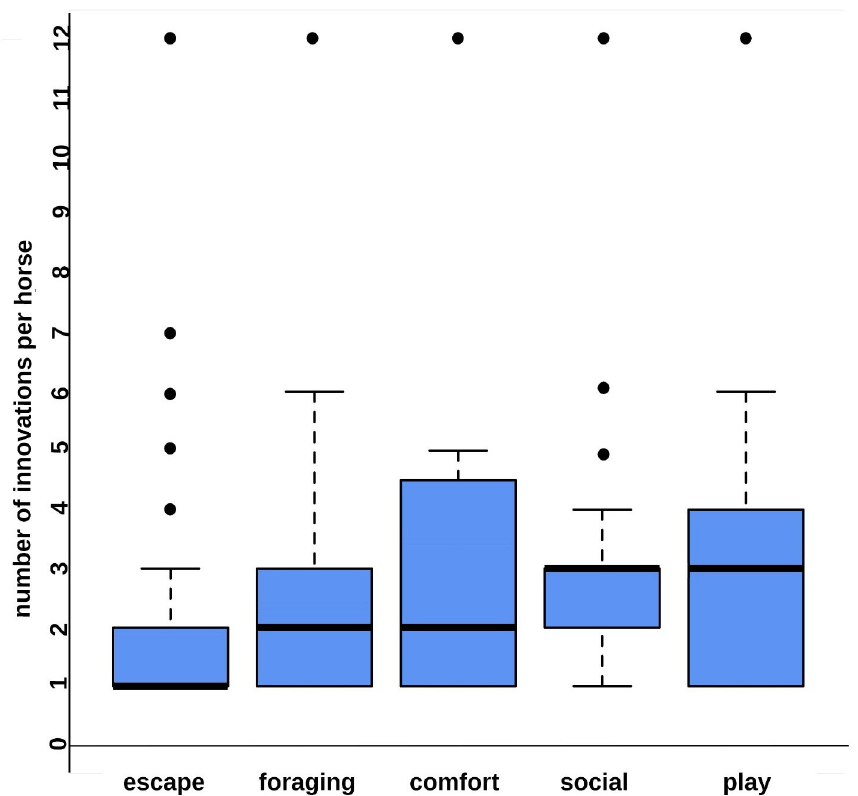
Fig 1. Number of types of innovations displayed per equid listed in the behaviour categories foraging, escape, social, comfort, and play. Each boxplot shows the quartiles of the number of innovations displayed per horse in each category. The box comprises 50% and the lower and upper whisker 25% of the variability each. The bold line provides the median, and the dots visualize outliers. Some equids displayed more than one innovation in a category but were considered in each behaviour category only once to avoid a bias in the median through